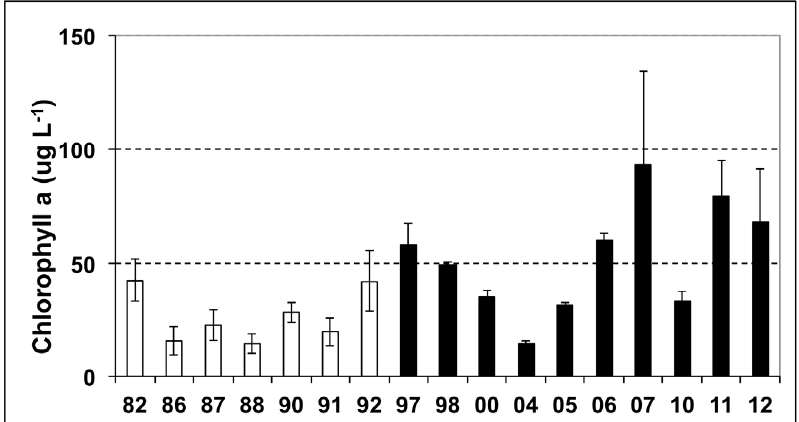
Figure 2. Mean summer Chlorophyll a concentration (±1 SEM) for lower bay site GB2 in Green Bay. Open bars are pre-invasion years, black bars are post-invasion